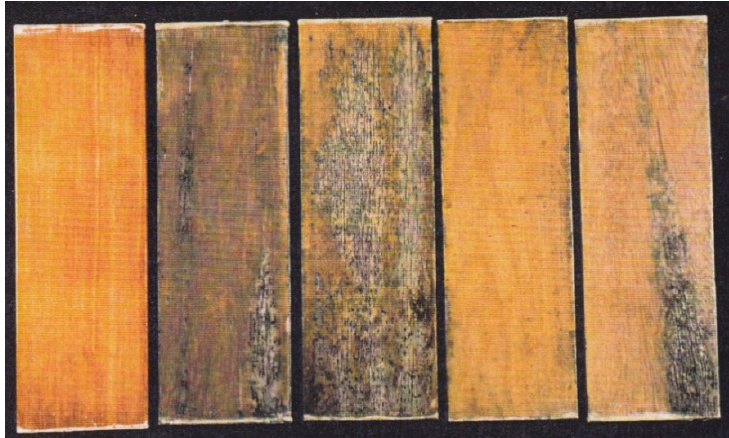
Figure 7. Effect of adding a UV absorber and hindered amine light stabilizer (HALS) to a clear coating on the performance of clear-coated kempas wood panels exposed to the weather for 18 months in Malaysia. From left to right: Unweathered control; weathered control; coating containing 2% benzotriazole UVA; coating containing 2% benzotriazole UVA and 2% HALS; coating containing 2%